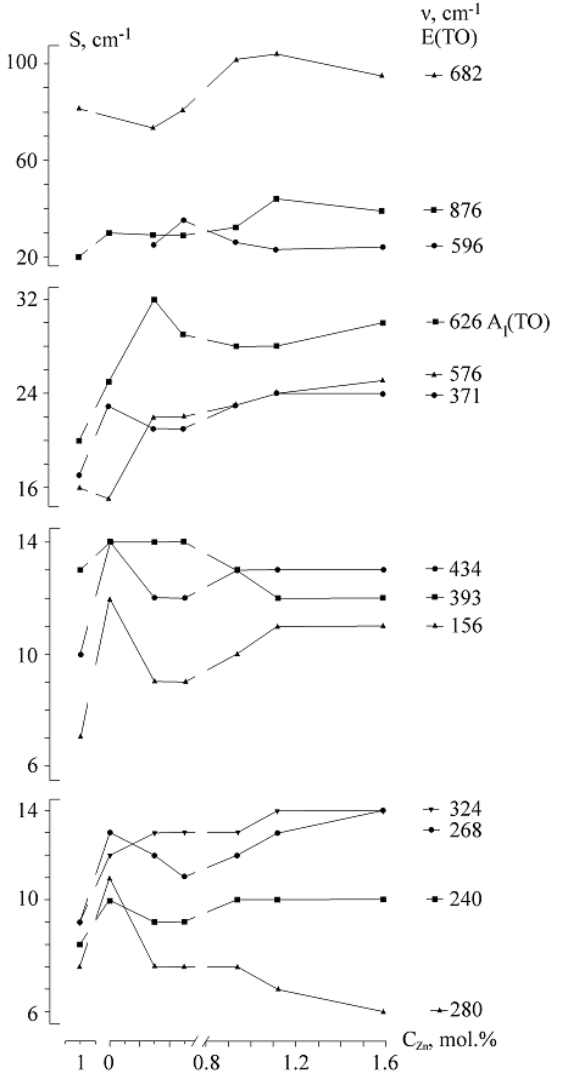
Figure 24. Dependence of widths of Raman bands of LiNbO 3 :Zn crystals on the Zn 2+ concentration. The dotted line indicates the change in widths of the bands upon transition from a SLN (1) to a CLN crystal (0). The figure is reproduced with the permission of Pleiades Publishing, Ltd. from the paper Inorg. Mater.: Appl. Res. 2016, V. 7, P. 170-176. doi: 10.1134/S2075113316020209.